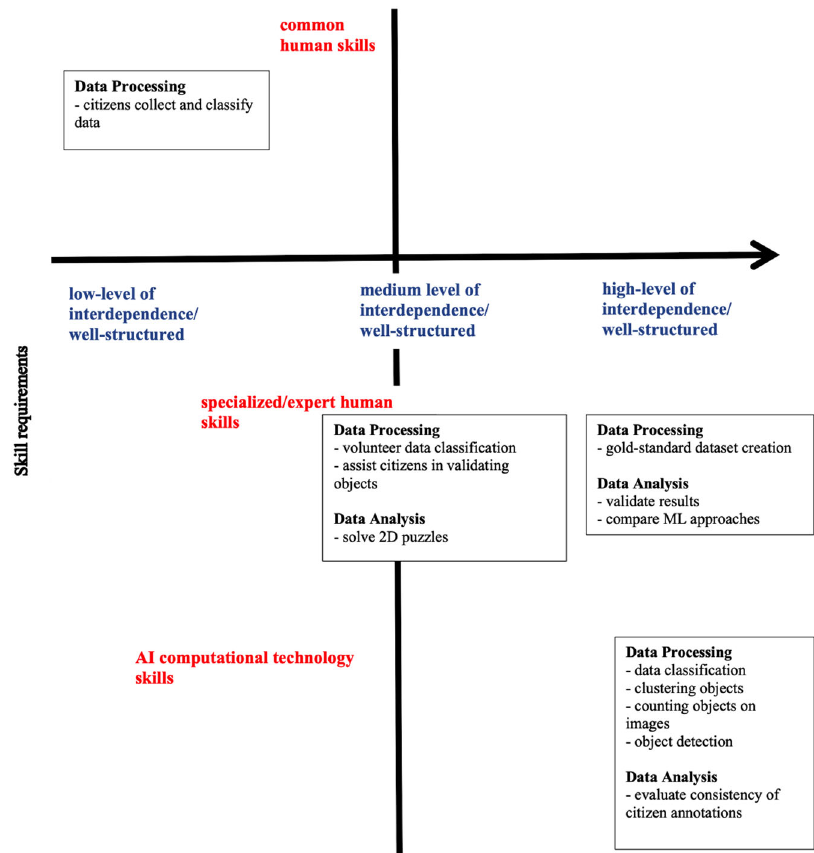
Fig. 2 Nature of the task outsourced to humans and AI computational